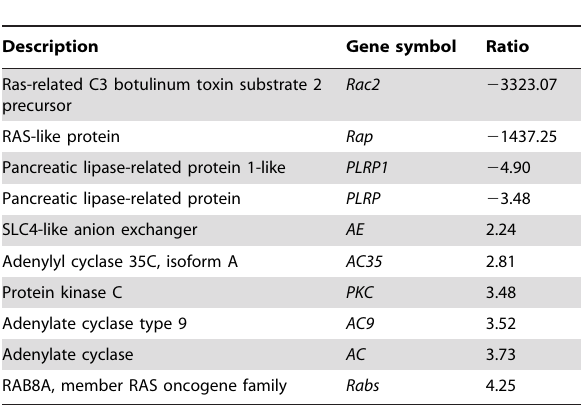
Table 6. Genes in pancreatic secretion pathway.